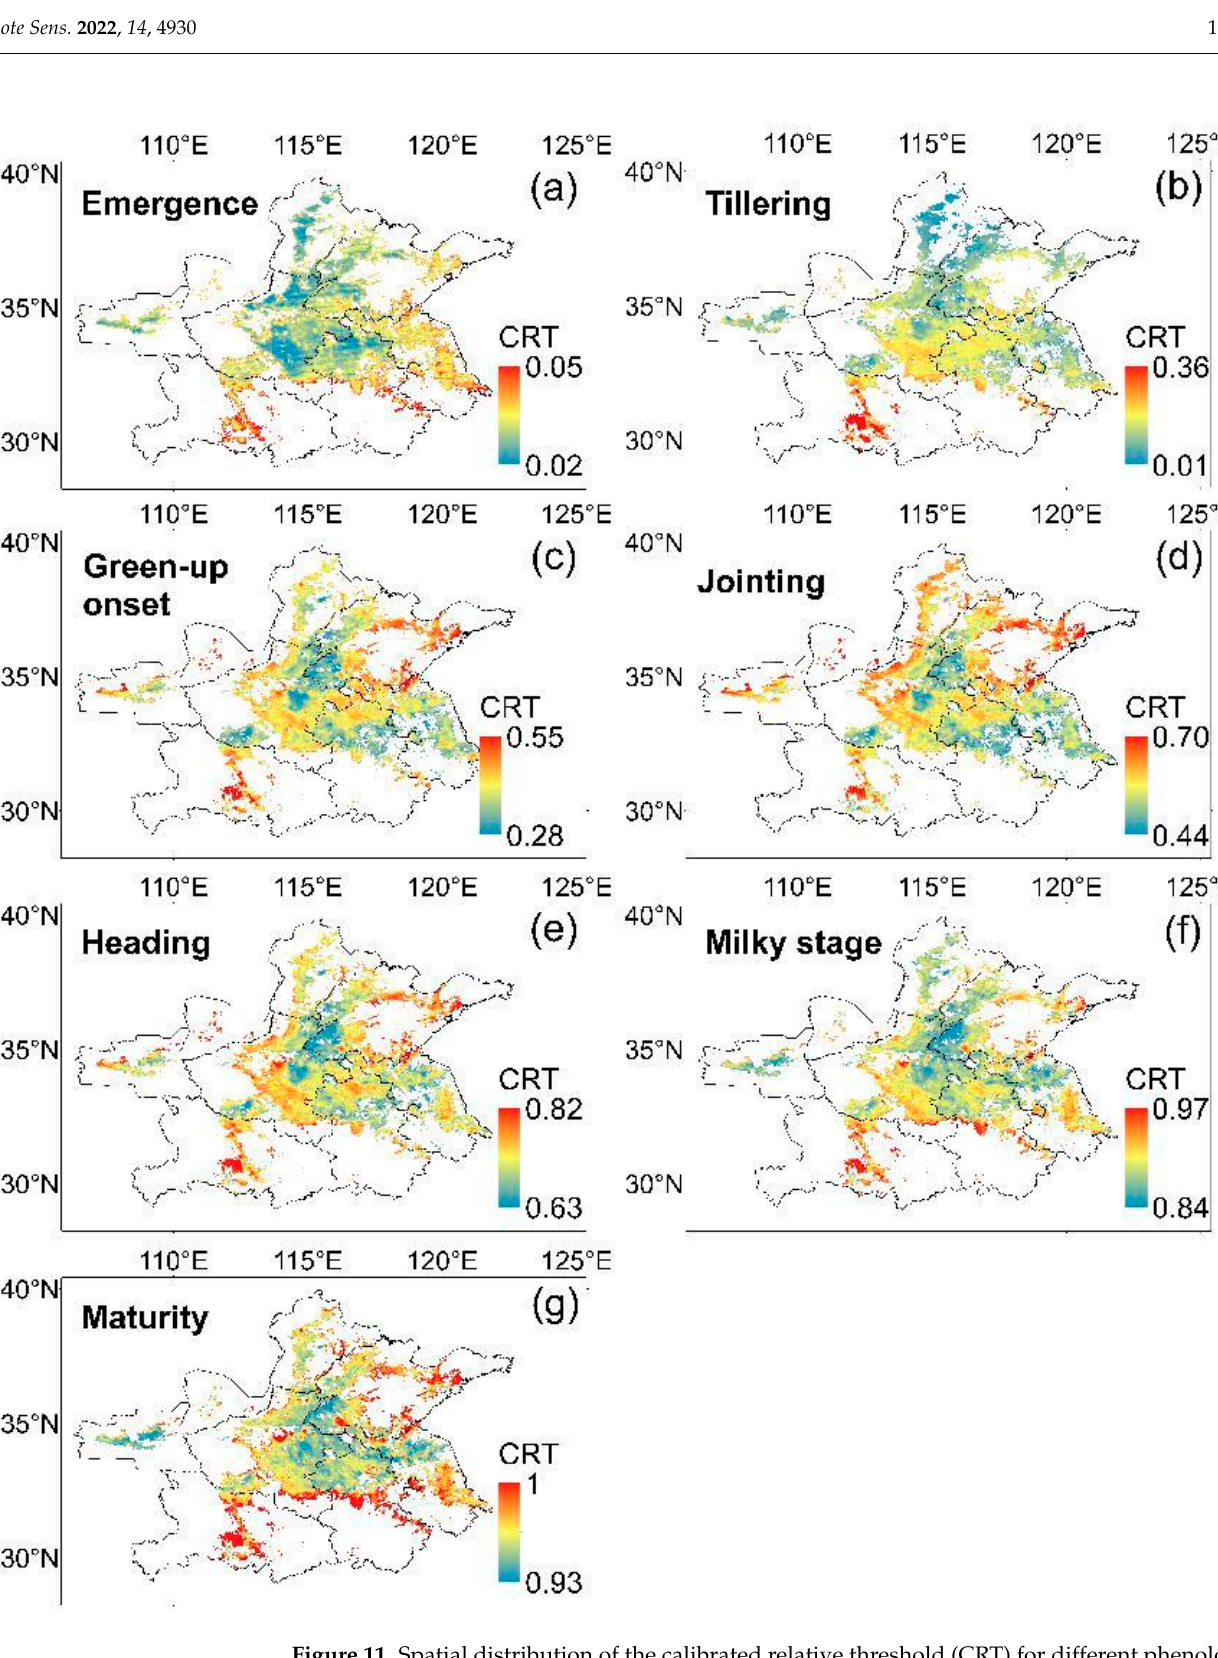
Figure 11. Spatial distribution of the calibrated relative threshold (CRT) for different phenological dates based on ground-based phenological observations. ( a ) illustrates spatial distribution of CRT for emergence, ( b ) illustrates spatial distribution of CRT for tillering, ( c ) illustrates spatial distribution of CRT for green-up onset, ( d ) illustrates spatial distribution of CRT for jointing, ( e ) illustrates spatial distribution of CRT for heading, ( f ) illustrates spatial distribution of CRT for milky stage, and ( g ) illustrates spatial distribution of CRT for maturity, respectively.